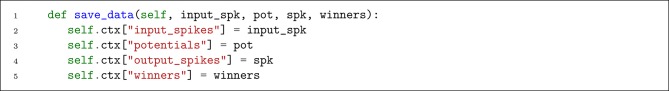
Saving required data for plasticity.